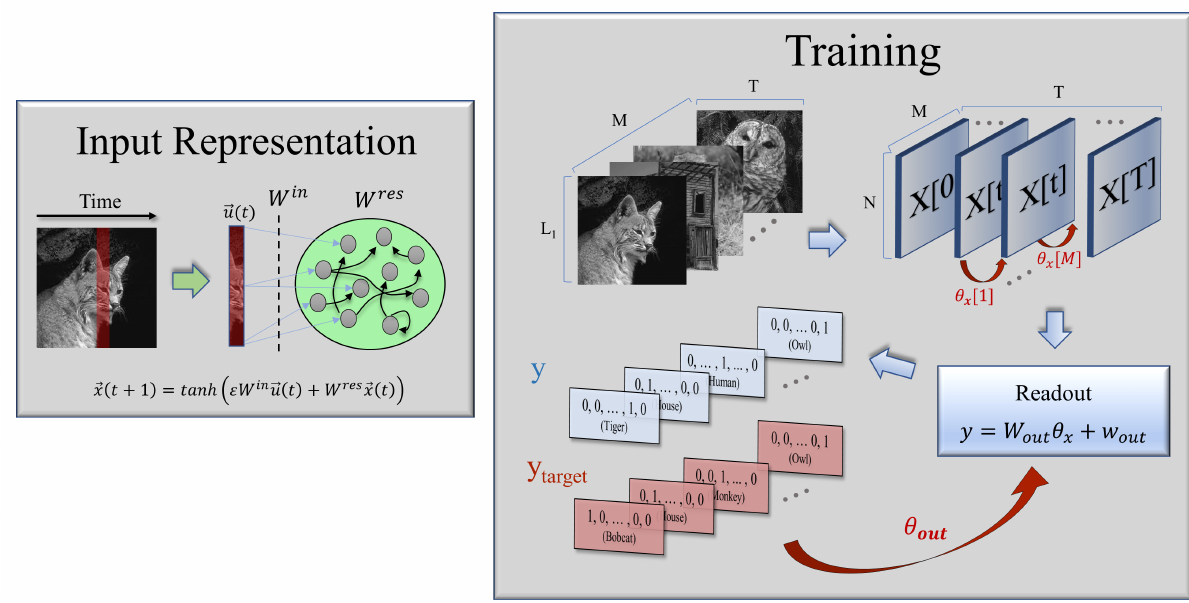
Figure 1. Sketch of the echo state network and the image classification task. Left: Images are converted to multivariate time series and then fed into the reservoir. Right: for each processed image a set of parameters θ x is generated, which characterizes the high-dimensional state of the reservoir, i.e., the “ reservoir model space ”. These are then fed into the readout module, which linearly transforms the information in the reservoir model space into an output label. Finally, output weights ˜ W out are generated by minimizing the error between the predicted and target labels. Red arrows indicate steps in which a Ridge regression is